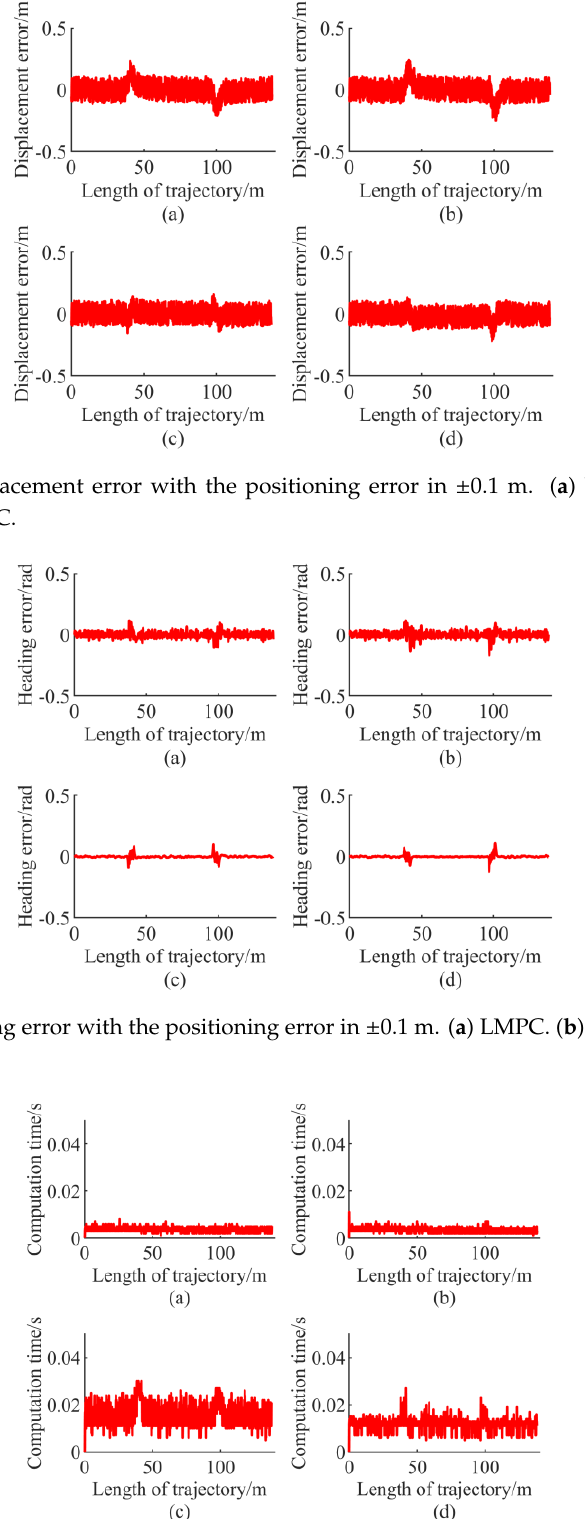
Figure 32. The computation time with the positioning error in ± 0.1 m. ( a ) LMPC. ( b ) LEMPC. ( c ) NMPC. ( d ) NEMPC.